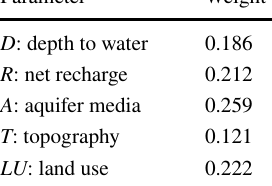
Table 9 Weights for each